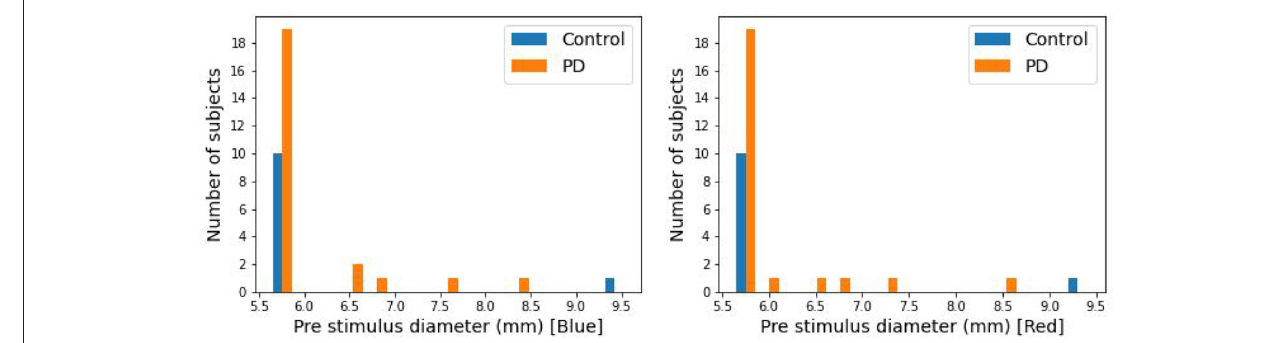
FIGURE 2 | Distribution of pre-stimulus pupil diameter.